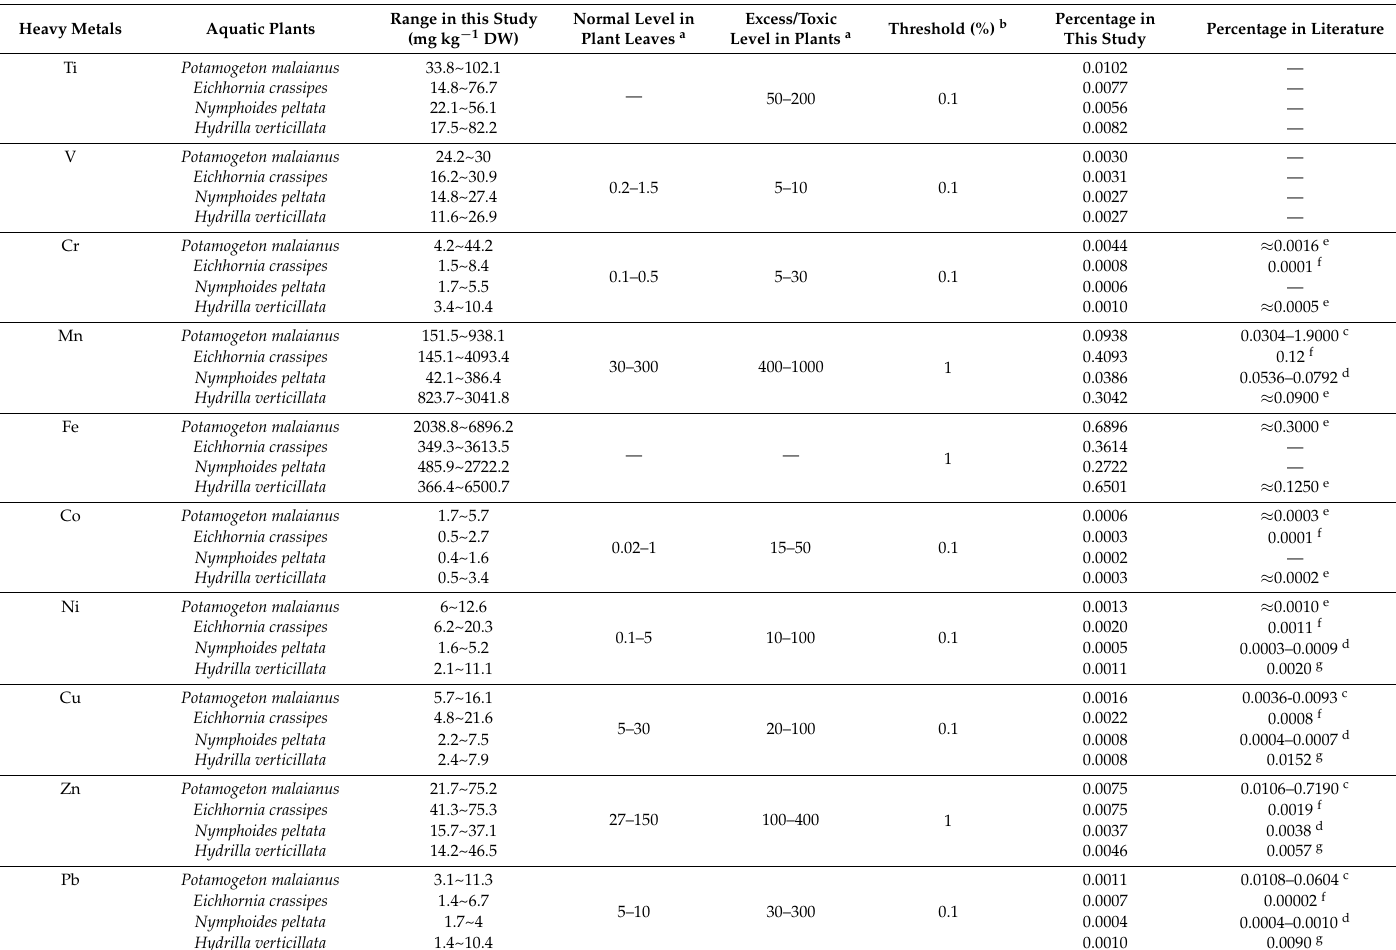
Table 2. Concentration and accumulation of heavy metals in aquatic plants in Taihu